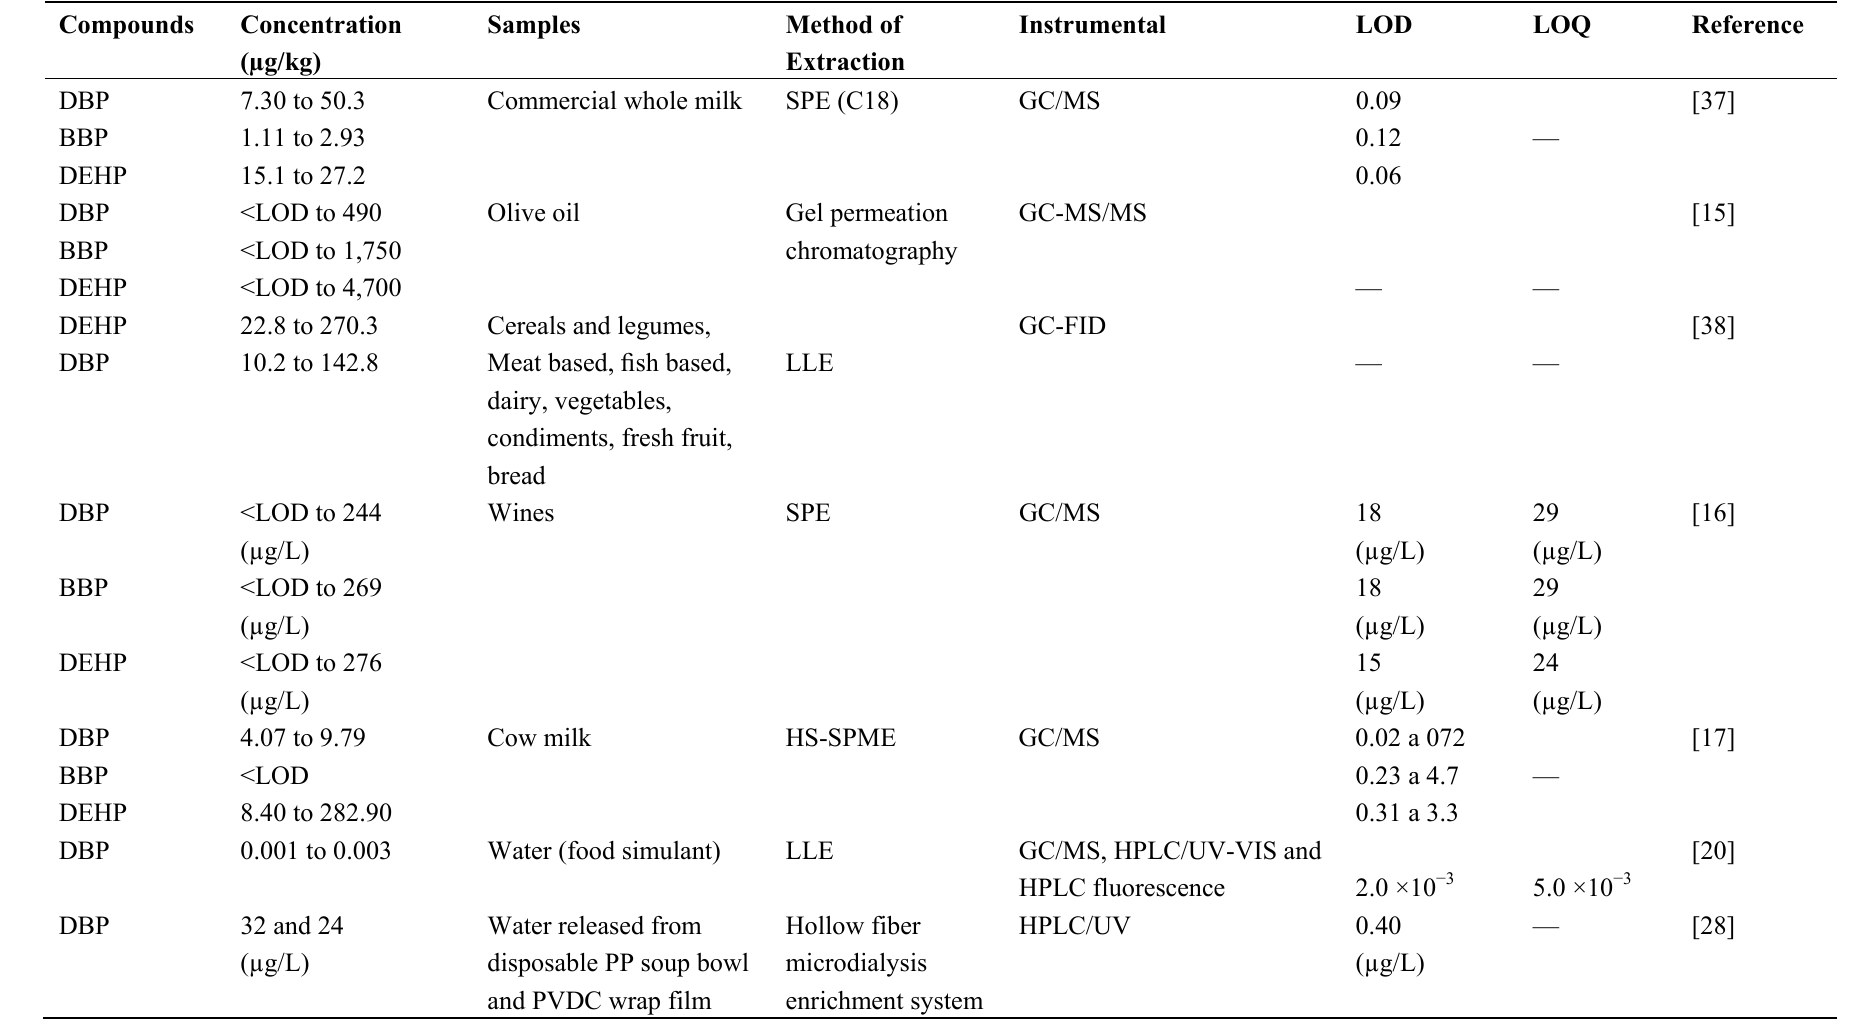
Table 4. Phthalate concentrations that have been reported in the